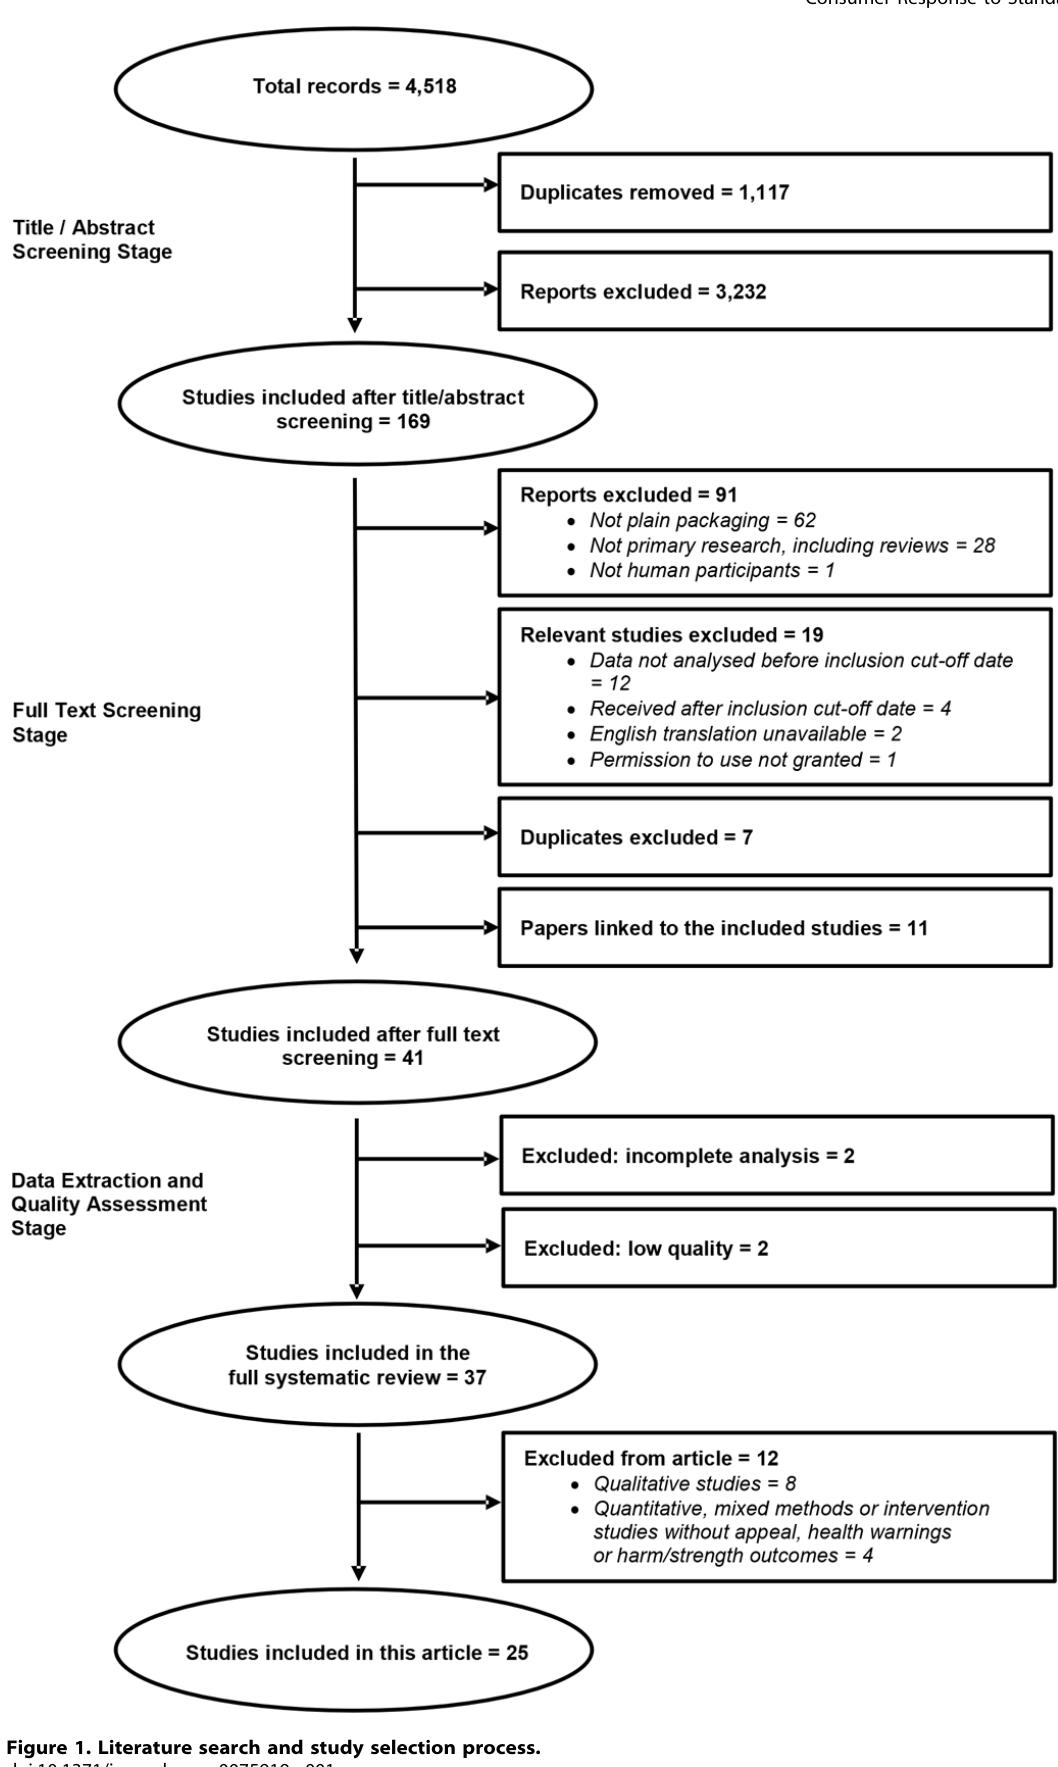
Figure 1. Literature search and study selection process. doi:10.1371/journal.pone.0075919.g001 PLOS ONE |